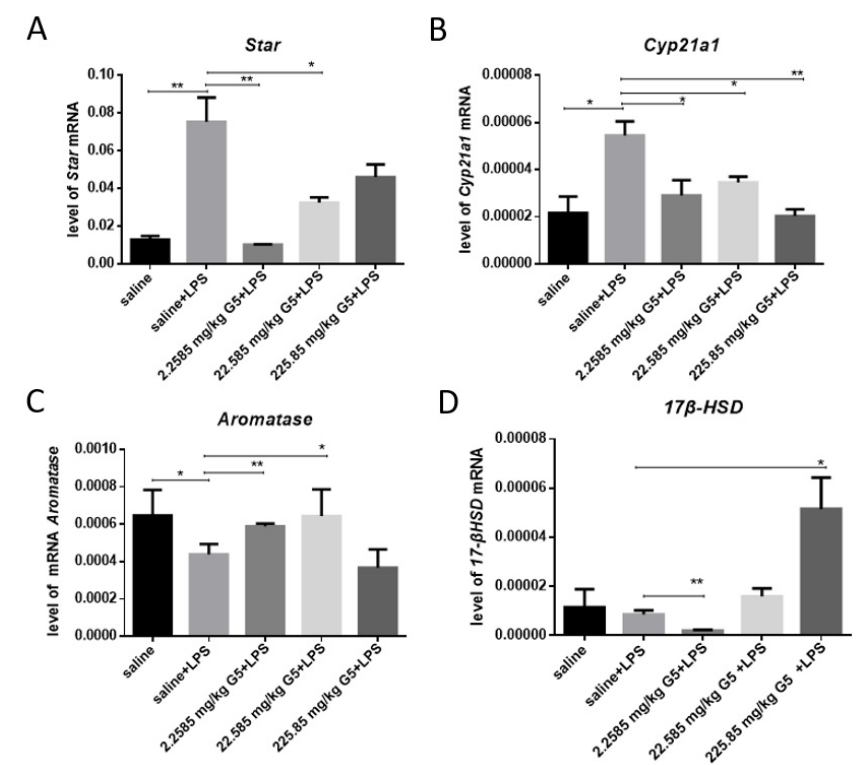
Figure 6. Effect of G5 on the level of gene expression in LPS-induced depression mouse. Ovaries were collected 48 h post-LPS challenge and subjected to mRNA extraction and Q-RT-PCR. Gene expression of ( A ) Star, ( B ) Cyp21a1, ( C ) aromatase, and ( D ) 17 β -HSD in hippocampus are presented. For statistical significance, * p < 0.05, ** p < 0.01 for one-way ANOVA followed by Fisher’s least significant difference test; n = 7, all data are presented as mean ± SEM.